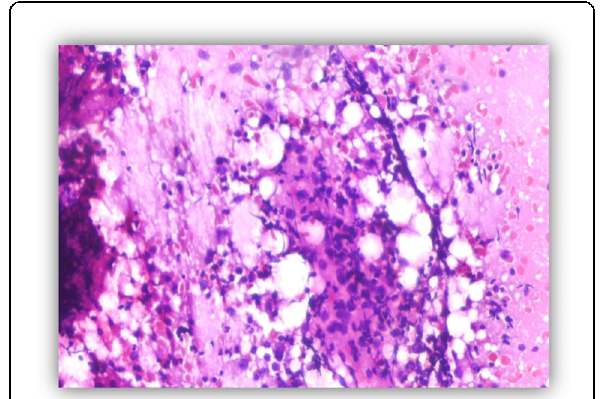
Fig. 6 Imprint cytology for tuberculous pleurisy